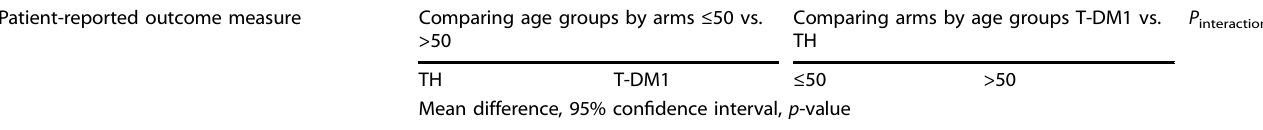
Table 5. Adjusted differences between age groups and treatment arms (interaction) in 18-month post-enrollment patient-reported outcomes. Patient-reported outcome measure Comparing age groups by arms ≤ 50 vs. Comparing arms by age groups T-DM1 vs. >50 TH